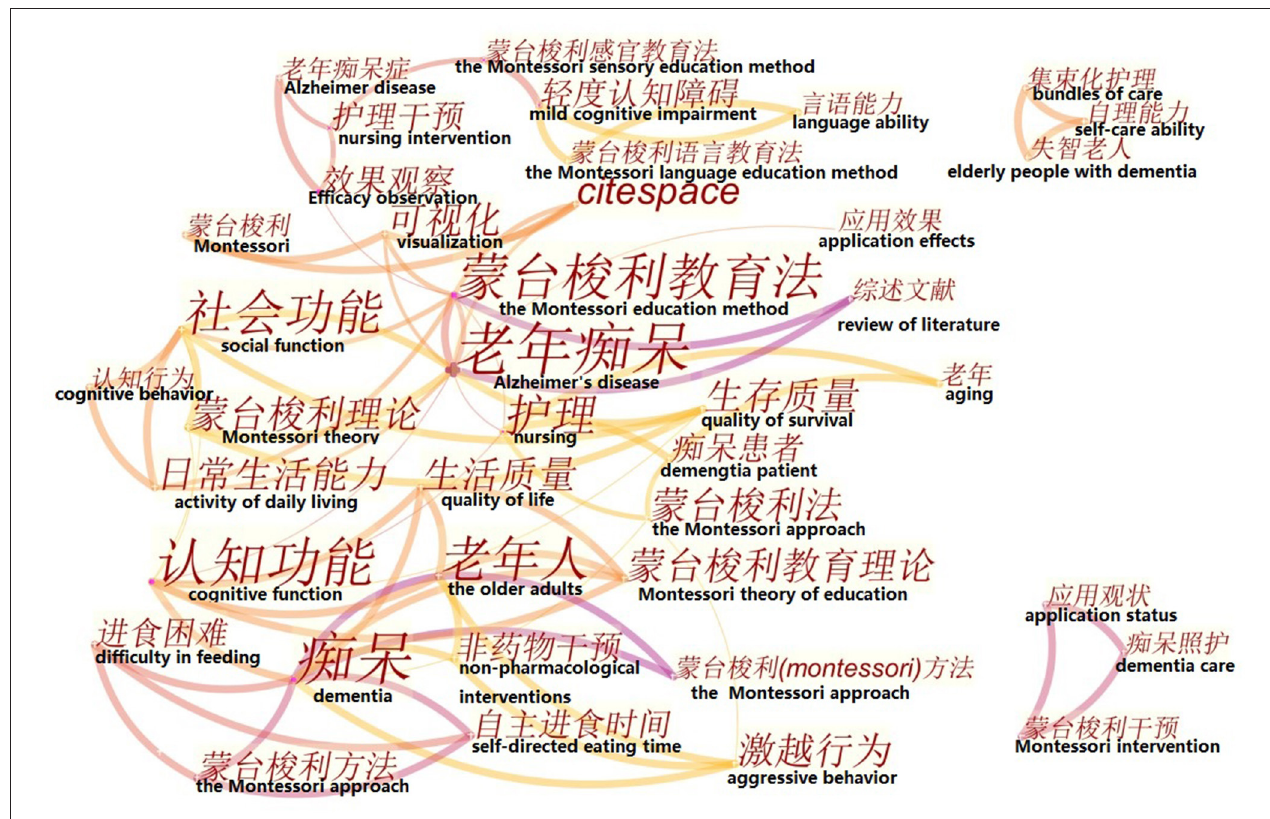
FIGURE 5 | Keyword co-occurrence graph of articles published in Chinese on Montessori approach to interventions for patients with dementia from 2000 to 2021.